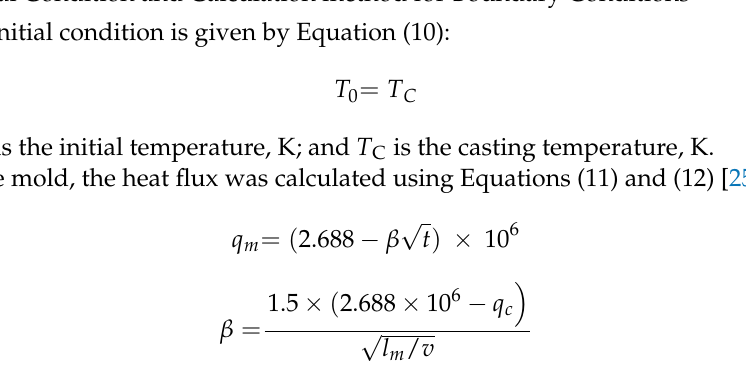
Figure 2. Variations in the thermo − physical parameters of steels with temperature: ( a ) thermal conductivity; ( b ) enthalpy; ( c ) density; ( d ) solid fraction.